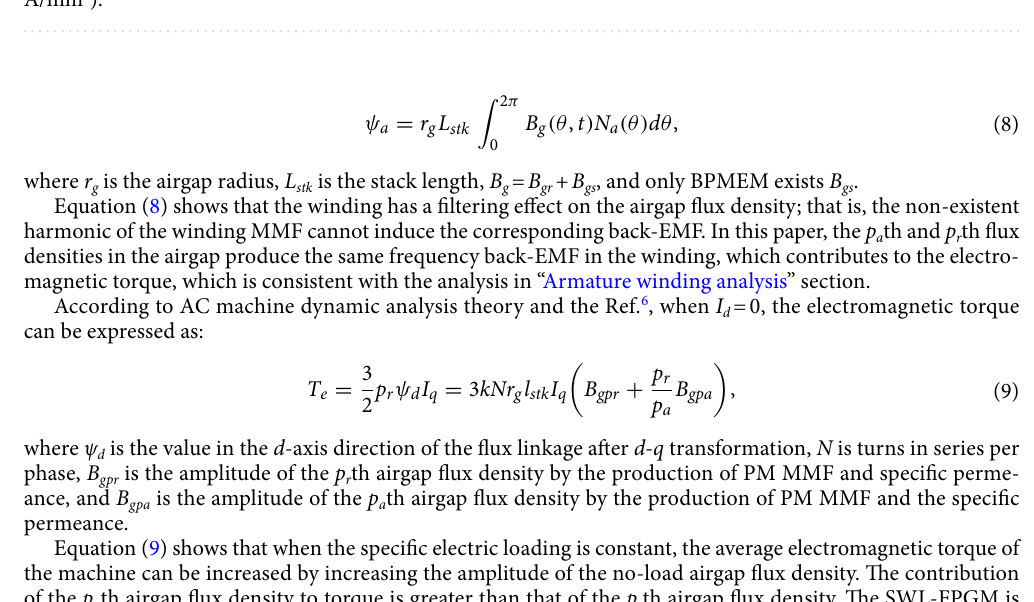
Figure 5. Electromagnetic characteristics. ( a ) No-load airgap flux density waveform, ( b ) no-load airgap flux density harmonic spectrum, ( c ) no-load flux linkage of the A-phase winding, and ( d ) electromagnetic torque (5 A/mm 2